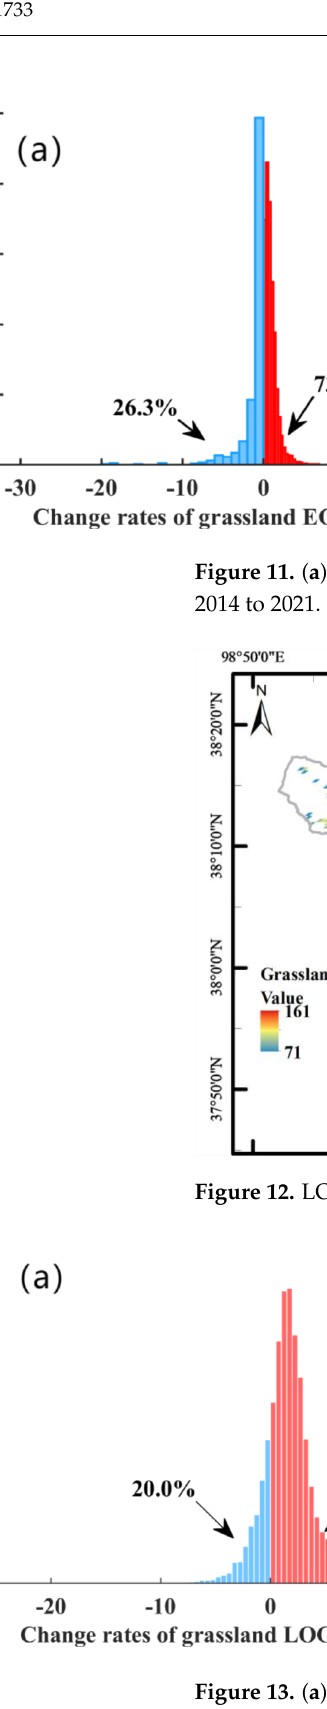
Figure 13. ( a ) LOG annual rate of change; ( b ) change rates of grassland LOG in the Muli region from 2014 to 2021 .